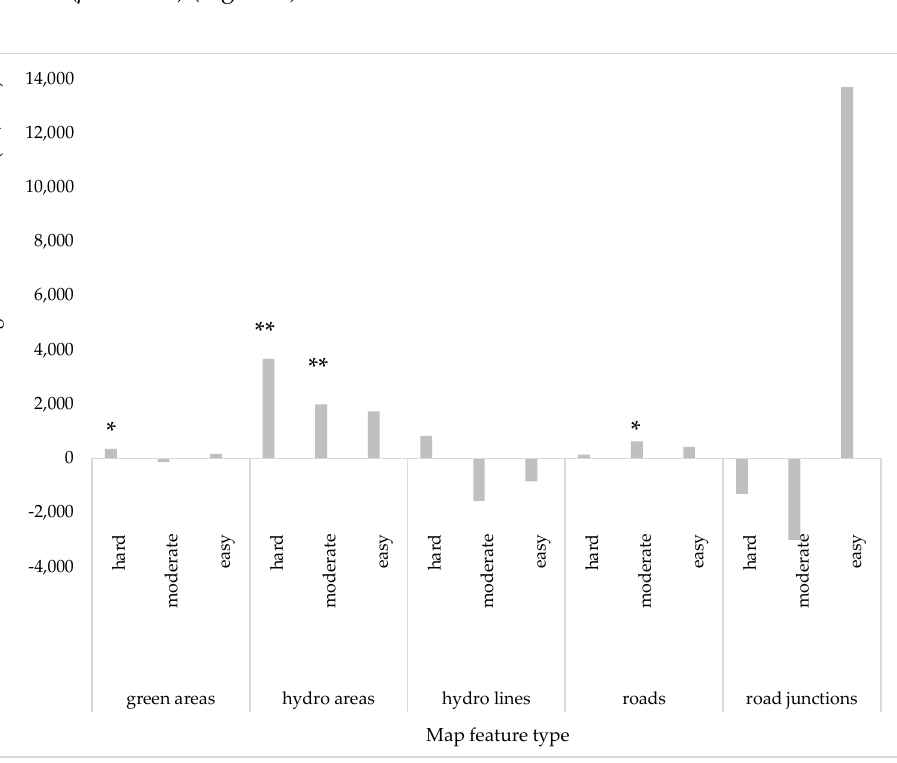
Figure 7. The differences in normalized average fixations for experts and novices while they study the task-relevant (within-AOI) areas. For inferential statistics, please see Expertise × Map feature type × Task difficulty interaction in the bullet list above. Above zero is more attention by experts, below zero is more attention by novices. *** p < 0.001, ** p < 0.01, * p < 0.05, p <